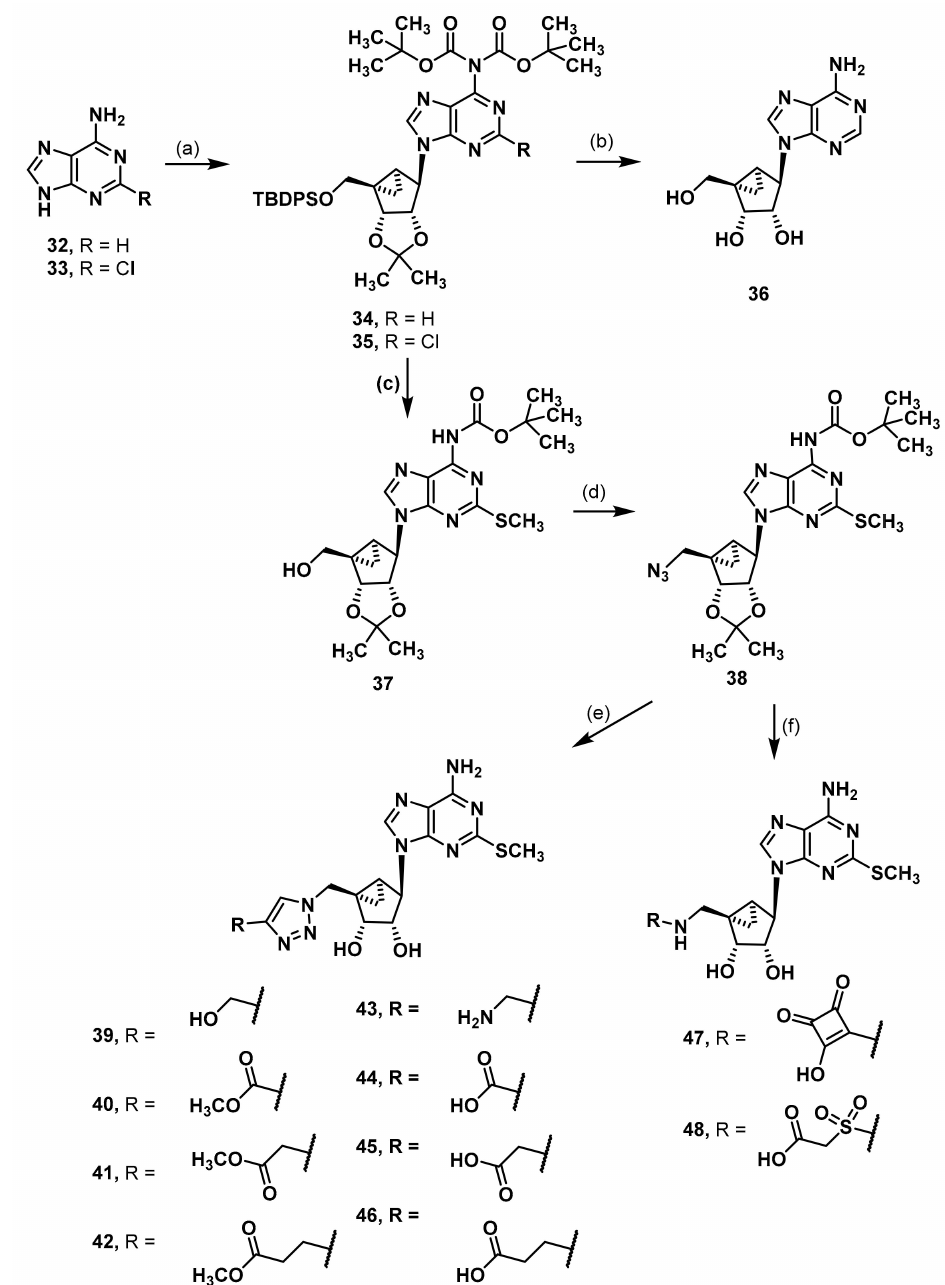
Scheme 5. Synthesis of (N)-methanocarba adenosine 33 and derivatives modified at the 5 (cid:48)